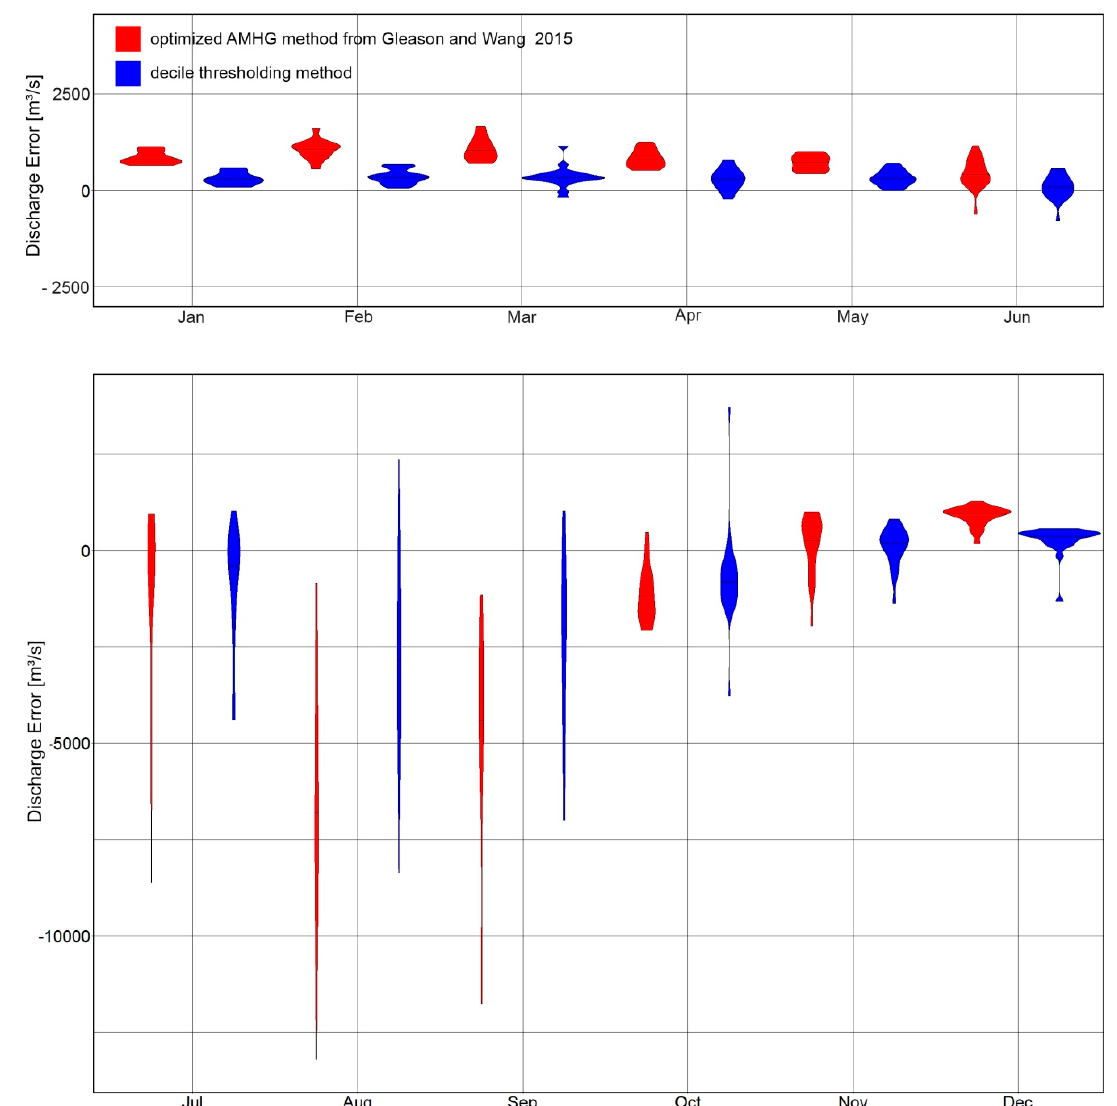
Figure 17. Violin plot for monthly cumulated error between optimized AMHG discharge estimation, decile thresholding method and observed discharge.